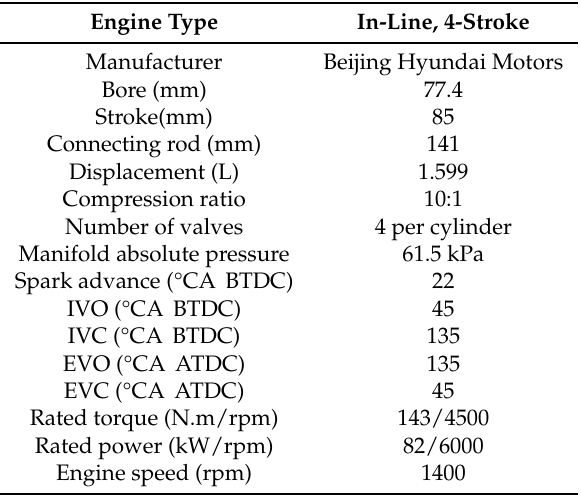
Table 1. Engine specifications [8] and operation parameters considered. ATDC applies for after top dead center and BTDC for before top dead